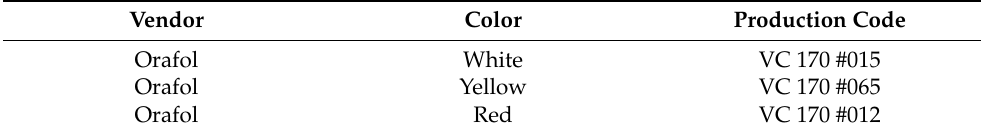
tion codes. Table 2. Retroreflective foils of the vendor Orafol with the corresponding colors and the production codes.